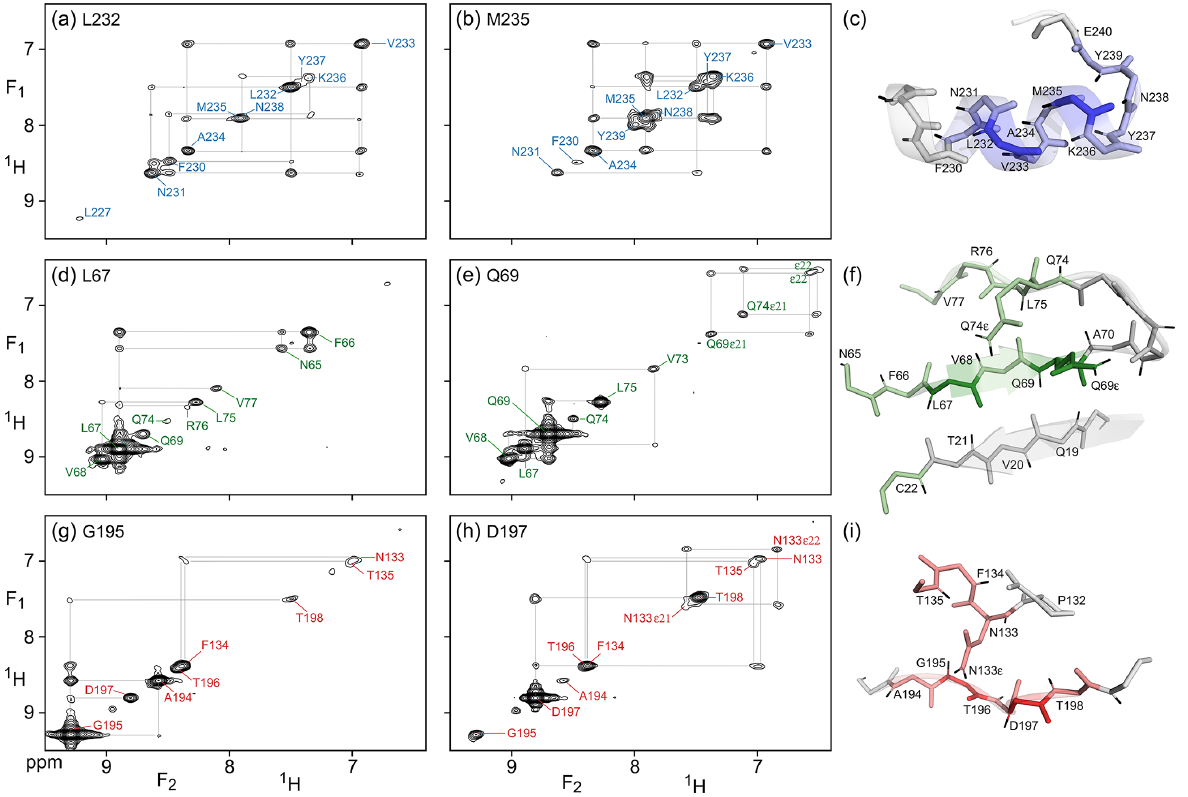
pro , taken orthogonal to the ( F 3 , F 4 ) TROSY- C145A